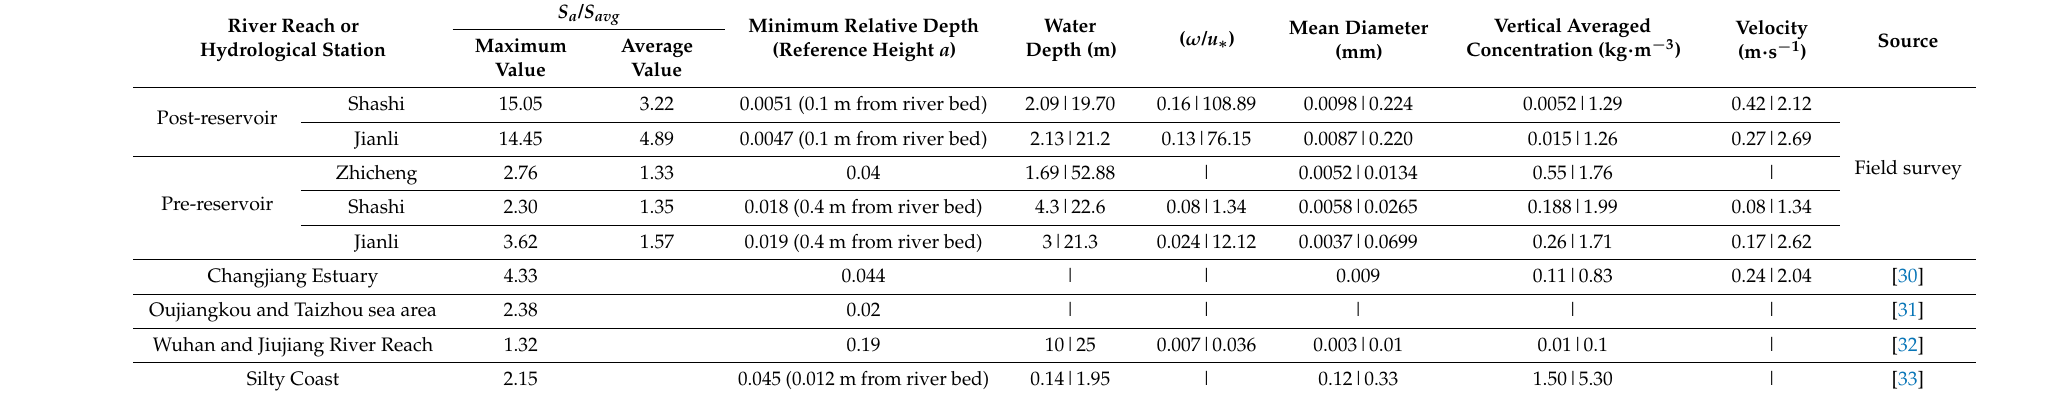
Table 2. Statistical characteristics of vertical